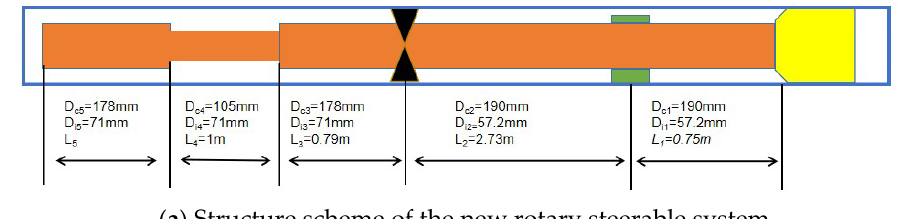
( b ) 45° data plot ( c ) 90° data plot Figure 9. Influence of the length from paranoid mechanism to centralizer (L2) on trajectory control capacity of the tool. 4.5. The Optimal Structure Scheme of the New Rotary Steerable System and the Comparison